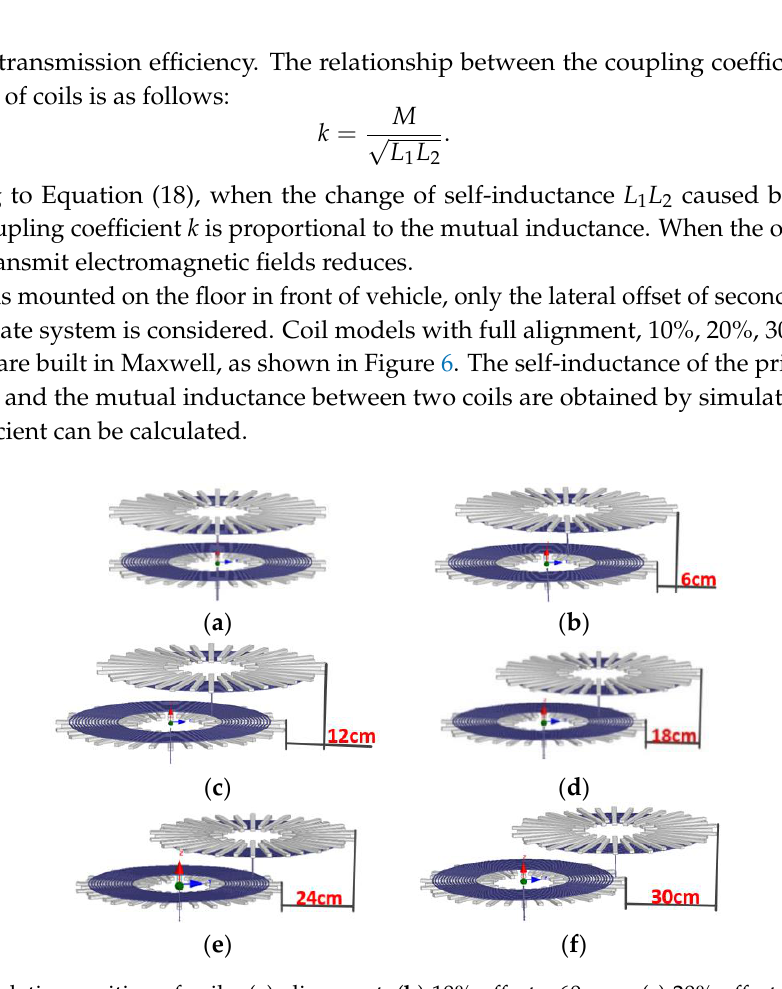
Figure 6. Relative position of coils: ( a ) alignment; ( b ) 10% offset—60 mm; ( c ) 20% offset—120 mm; ( d ) 30% offset—180 mm; ( e ) 40% offset—240 mm; ( f ) 10% offset—300 mm.